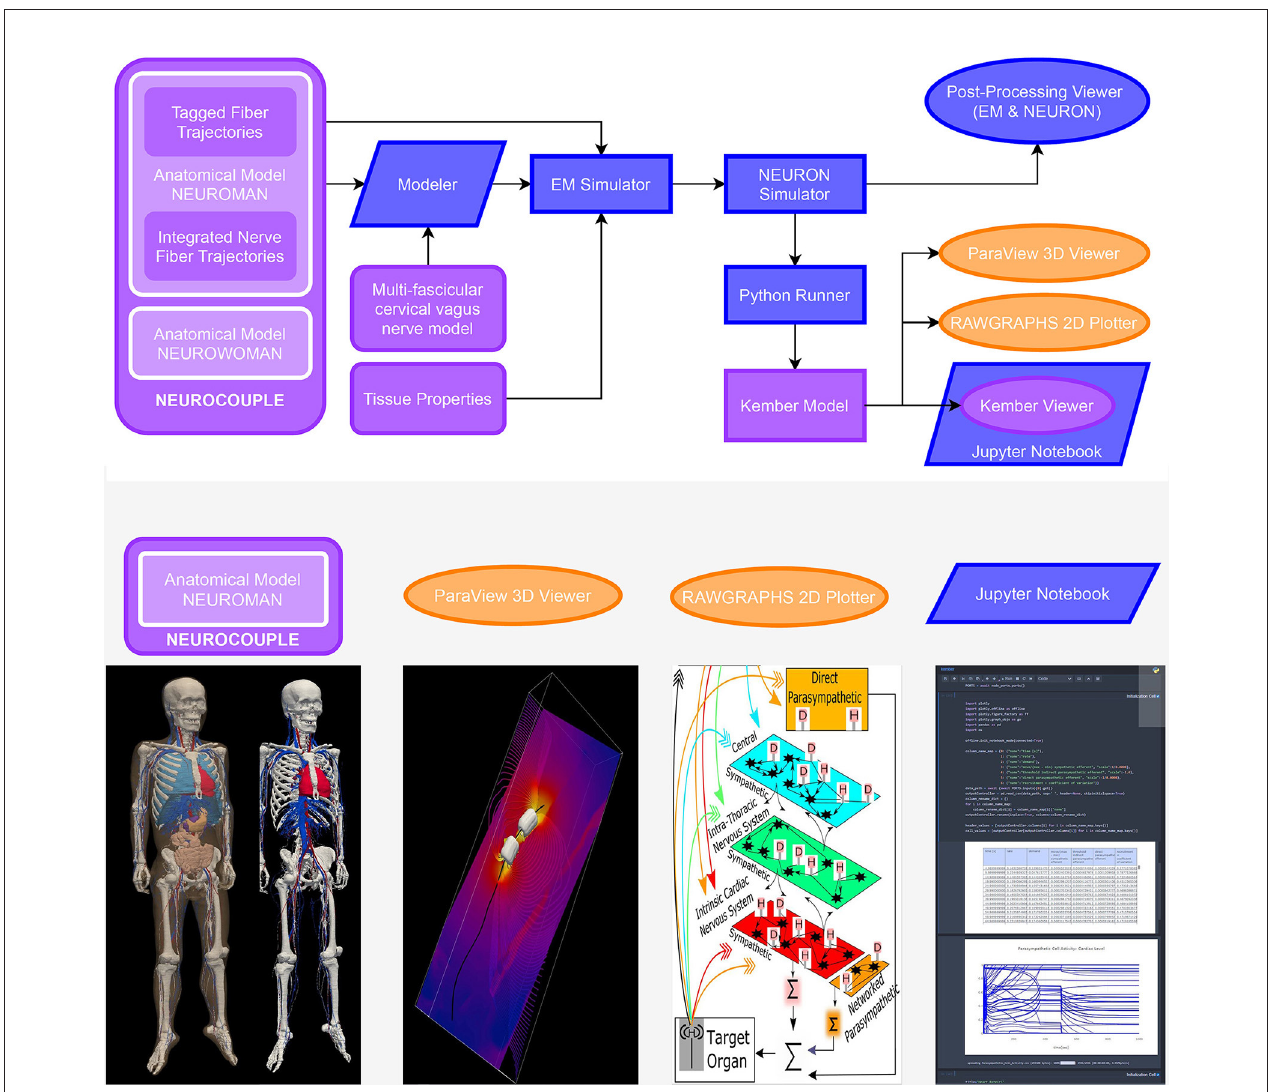
FIGURE 10 | Biophysical modeling and analysis workflow implemented at the end of the first o 2 S 2 PARC development year as a demonstrator of the feasibility of an open, readily extensible, online-based platform for collaborative computational neurosciences. (purple: published on the portal, blue: o 2 S 2 PARC services, yellow: 3rd party viewers embedded in o 2 S 2 PARC) Electromagnetic exposure of the vagus nerve by a bioelectronic implant is simulated, along with the resulting vagus nerve stimulation and its impact on cardiovascular activity: A “NEUROCOUPLE” service injects the male NEUROMAN anatomical model, along with a multi-fascicular cervical vagus nerve model layer and integrated nerve fiber trajectories, into a “Modeler” service, where interactive constructive geometry is used to integrate an implant electrode geometry. The different NEUROMAN anatomical regions are already tagged with tissue names and the fiber trajectories with electrophysiological information (fiber type and diameter). The implant-enhanced anatomical model serves as input to an “EM Simulator” service, which obtains dielectric properties from a “Tissue Properties” service and assigns them to regions based on their tags. After defining boundary conditions, discretization, and solver parameters, the high-performance computing enabled electro-quasistatic solver is called. The resulting electric potential is injected into a “NEURON Simulator” service, which also receives the tagged fiber trajectories from the “NEUROCOUPLE” service as input and discretizes these trajectories into compartment with associated ion channel distributions (according to predefined, diameter-parameterized fiber models), produces input files for the neuronal dynamics simulator from NEURON, and executes the simulations using NEURON’s “extracellular potential” mechanism to consider the electric field exposure. A “Python Runner” service implements the computation of stimulation selectivity indices, which feed a “Kember Model” service that contains an implementation of the multi-scale cardiac regulation model from Kember et al. (2017). A “Paraview 3D Viewer” service and a “Rawgraphs Viewer” service provide result visualization. Finally, a “Kember Viewer” service performs predefined post-processing analysis on the output of the “Kember Model” service and visualizes the results. The “Kember Viewer” service is a specialized instance of the “Jupyter Notebook” service, which permits to present a (Python) script along with documentation in an interactively explorable and editable form. Selected components of this study (anatomical model, 3D visualization of EM field and neural activity, Kember cardiac regulation model, example JupyterLab service) can be found on https://sparc.science/data?type=simulation.